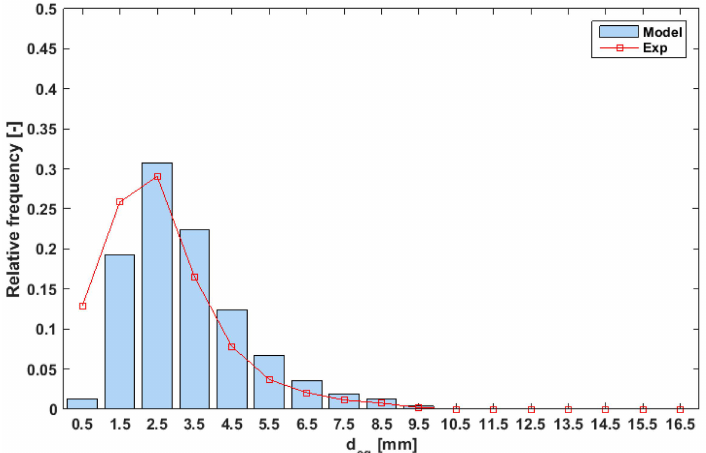
Figure 9. Comparison between PBM and experimental data: uniform BSD at the inlet: U G = 0.0111 m/s.